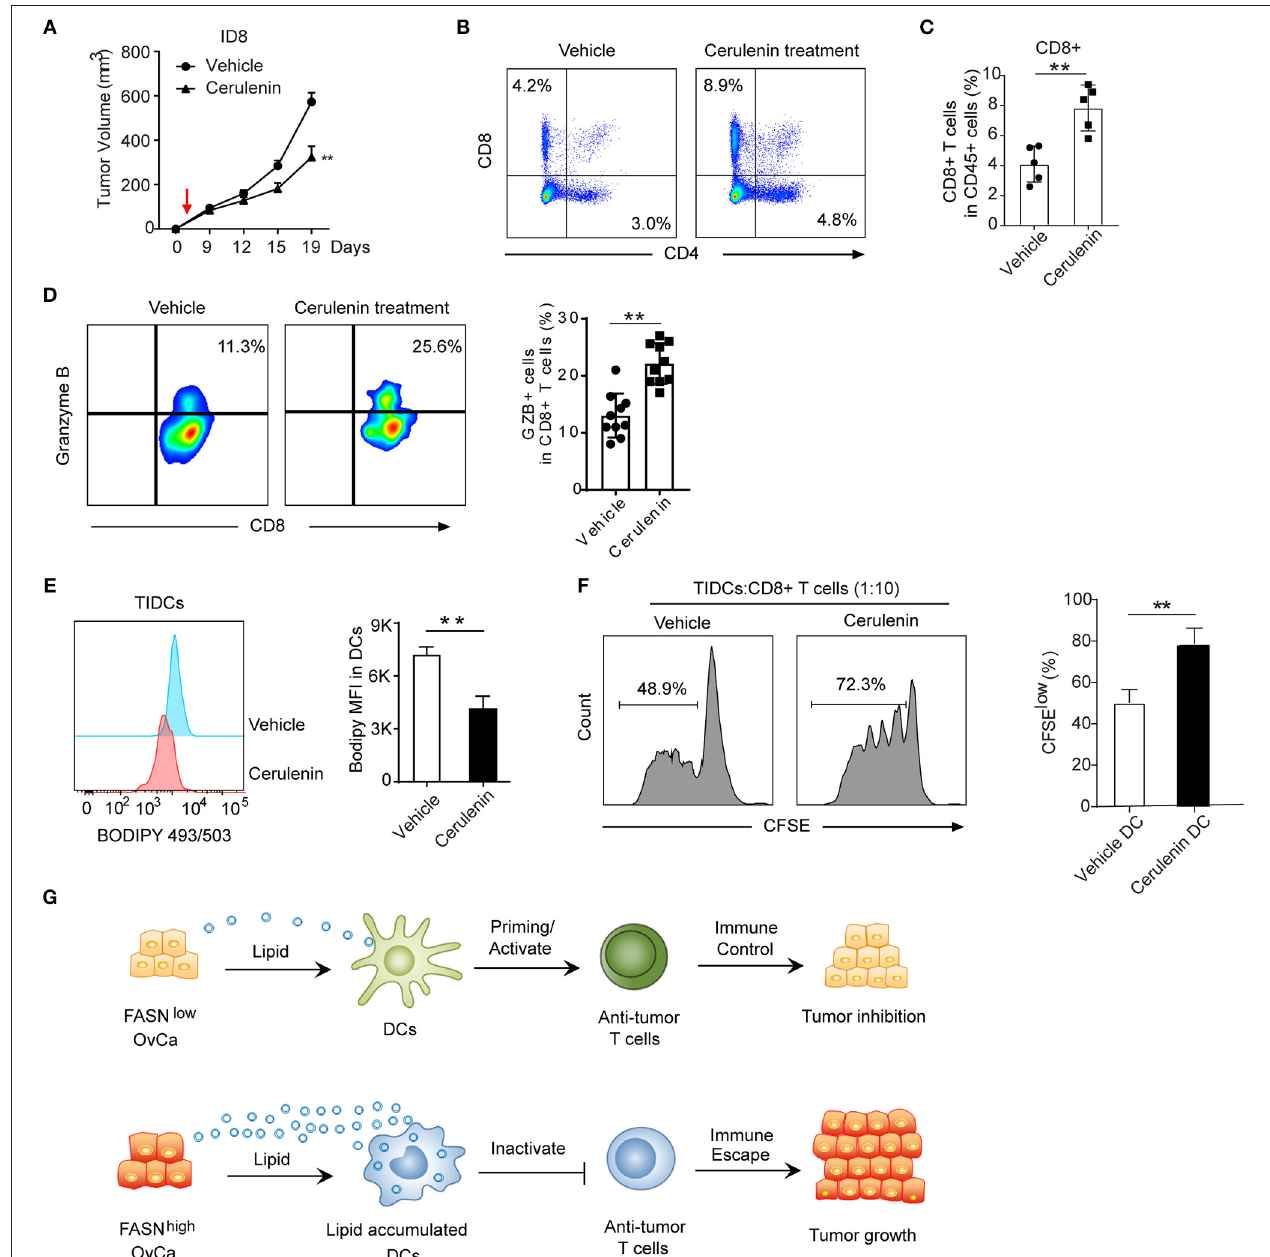
FIGURE 6 | Inhibition of FASN suppress OvCa progression by inducing an anti-tumor immune response. (A) Mean tumor volume of the subcutaneous ID8 tumor with the treatment of vehicle or cerulenin ( n = 10). The red arrow indicated the start of cerulenin treatment. (B) Representative flow cytometric analysis of CD8 + and CD4 + T cells populations in ID8 tumors with or without the treatment of cerulenin at 15 days post-implantation. (C) Quantification of CD8 + T cells population in ID8 tumors with or without the treatment of cerulenin at 15 days post-implantation ( n = 5). (D) Representative flow cytometric analysis and quantification of Granzyme B expression on CD8 + T cells population in ID8 tumor with or without cerulenin treatment at 15 days post-implantation. ( n = 10). (E) Representative flow cytometric analysis and quantification of lipid level in TIDCs sorted from the ID8 tumor with or without cerulenin treatment ( n = 5). (F) In vitro immunostimulatory activity of TIDCs sorted from the ID8 tumor with or without the treatment of cerulenin ( n = 5). Representative histograms and quantification of CD8 + T cell proliferation using CFSE dilution (right panel) were shown ( n = 3). Data presented as mean ± SEM; ** P < 0.01. (G) Summary of crosstalk between FASN low or FASN high tumor cells and DCs-mediated adaptive immune response as described in the